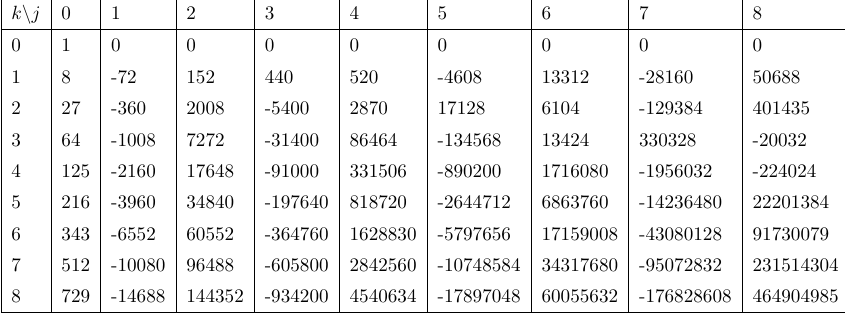
Table 27. Table of b jk coe(cid:14)cients for h SU(3)